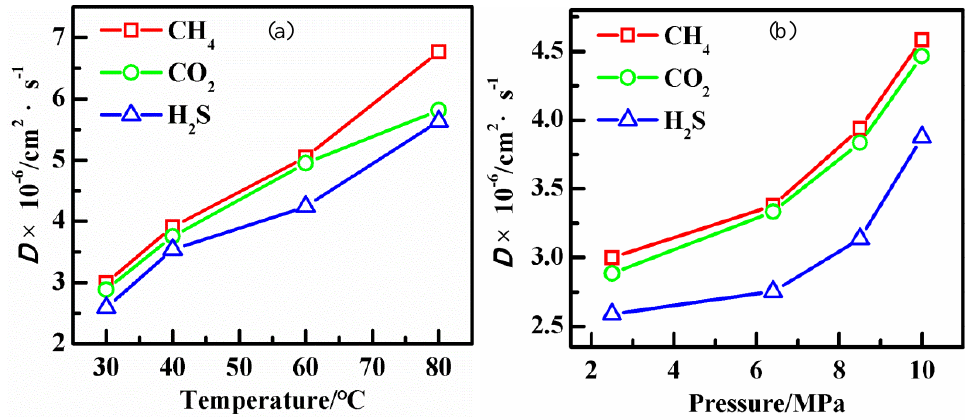
Figure 8. The diffusion coefficients of gases at different conditions: ( a ) 2.5MPa; ( b ) 30°C.